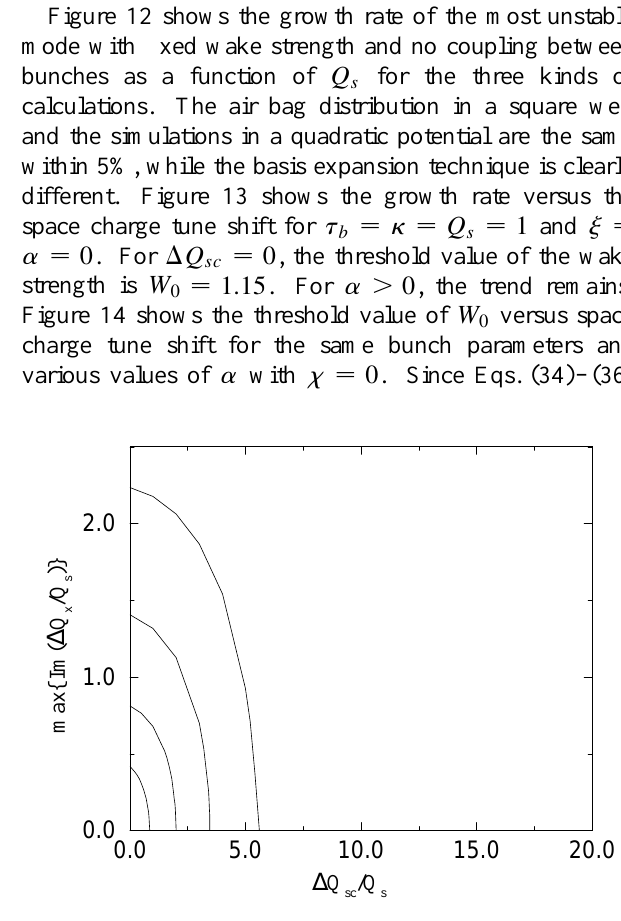
FIG. 13. Largest value of Im (cid:115) D (cid:81) (cid:120) (cid:121) (cid:81) (cid:115) (cid:100) vs D (cid:81) (cid:115)(cid:99) (cid:121) (cid:81) (cid:115) for the analytic square well model with